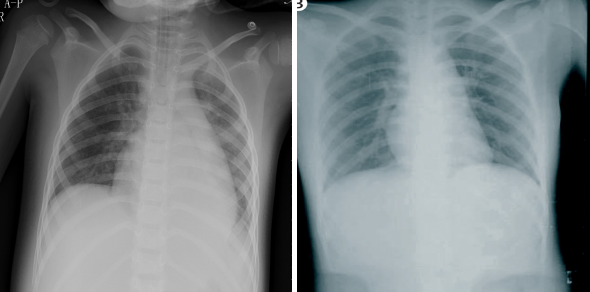
Figure 14. Example of unbalanced colors.